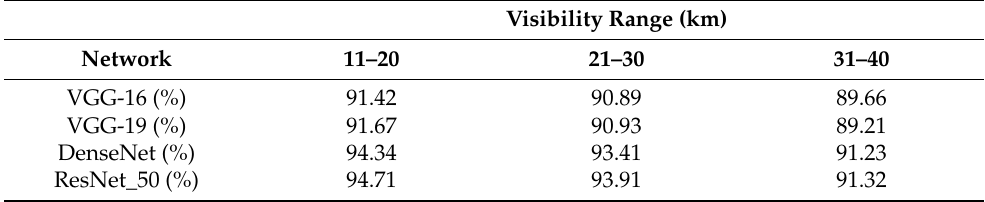
Table 3. Experimental results of different networks for different visibility